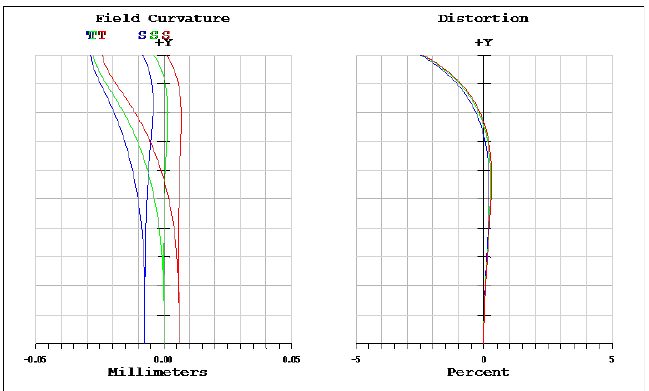
Figure 11. Field curvature ( left ) and distortion ( right ) of a miniaturized wide-angle fisheye lens using a polymethyl methacrylate (PMMA) aspheric lens.